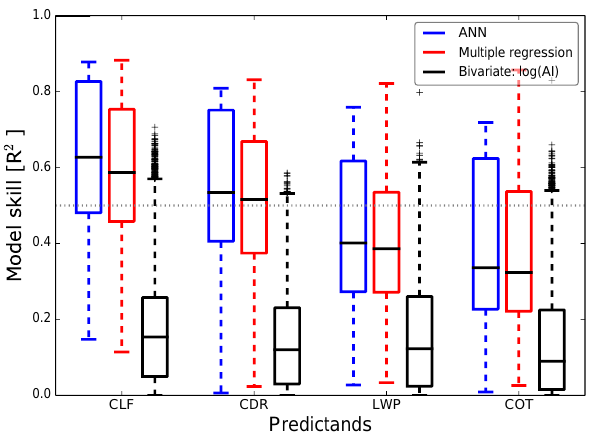
Figure 2. Predictand correlation with ANN test output, multiple lin- ear regression (both multivariate) and log(AI) (bivariate). The me- dians are represented by the black horizontal lines, framed by the interquartile range (boxes) and whiskers expand the boxes by 1.5 interquartile